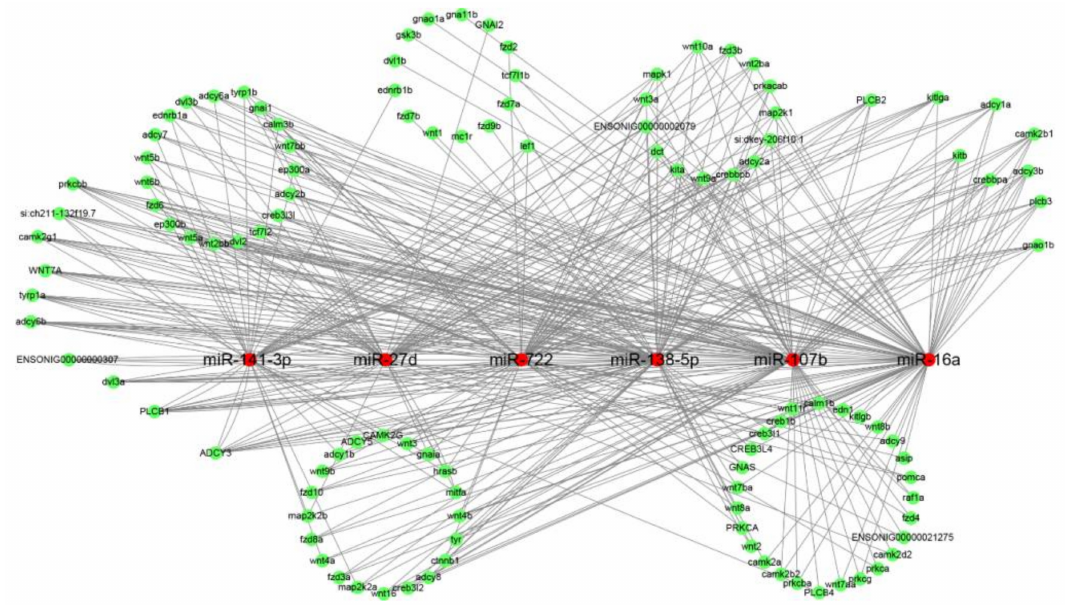
Figure 5. Network of putative interactions between miRNAs and their target genes related to the pigmentation process. The regulation network of miRNAs and their target genes was illustrated by Cytoscape. Red and green circles represent miRNAs and target genes,